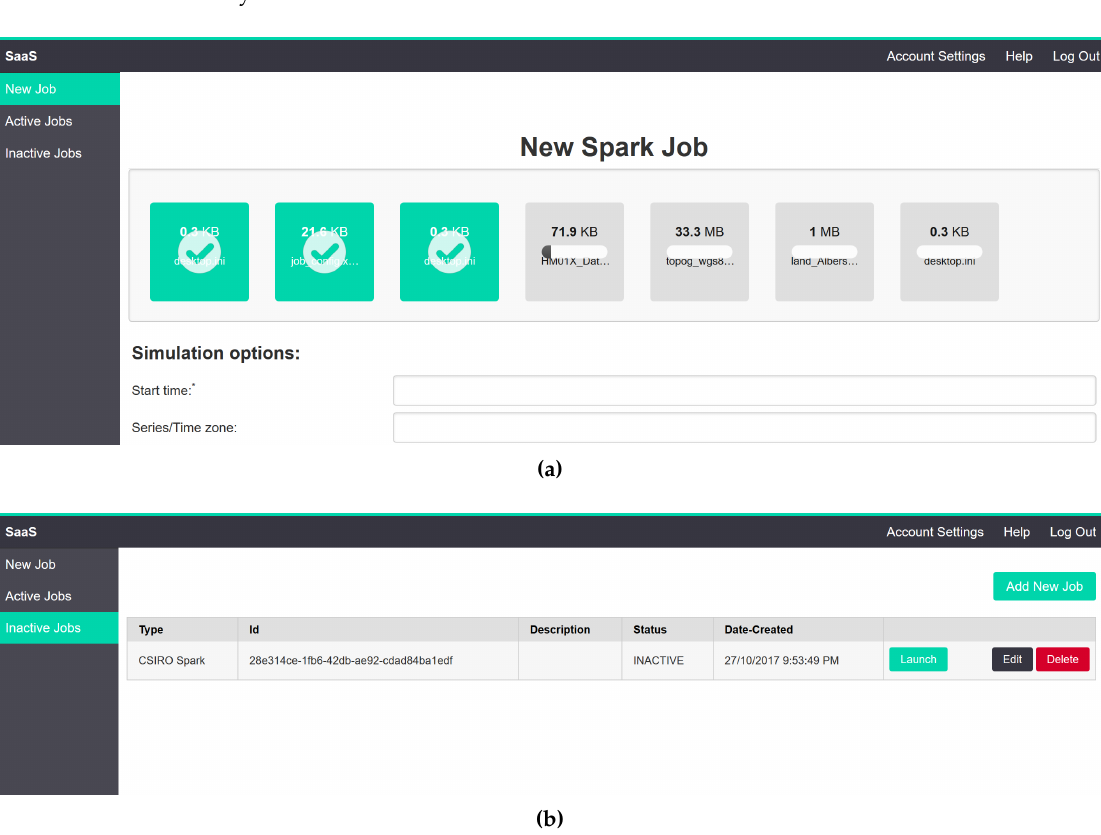
Figure 6. Spark benchmarking using real bushfire case studies. ( a ) Starting page view; ( b ) job